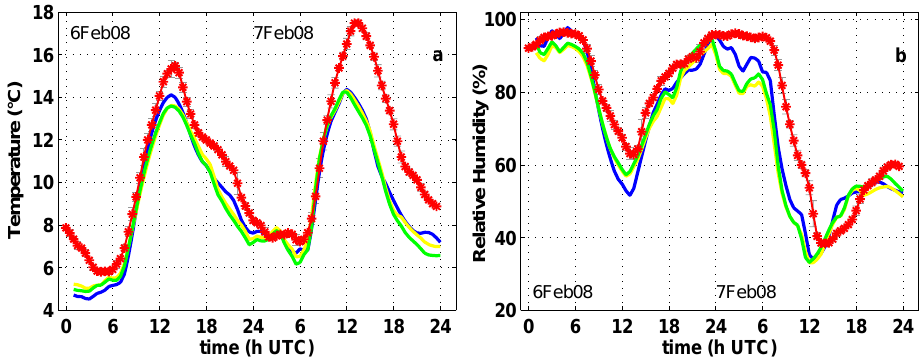
Fig. 4. Time series for temperature (a) and relative humidity (b) for 6–7 February 2008. Color code: YSUtd is blue; YSUNoahNOURB is yellow; YSUNoahUCM1 is green; measurements by probes combined with the sonic anemometer are red; and errors are